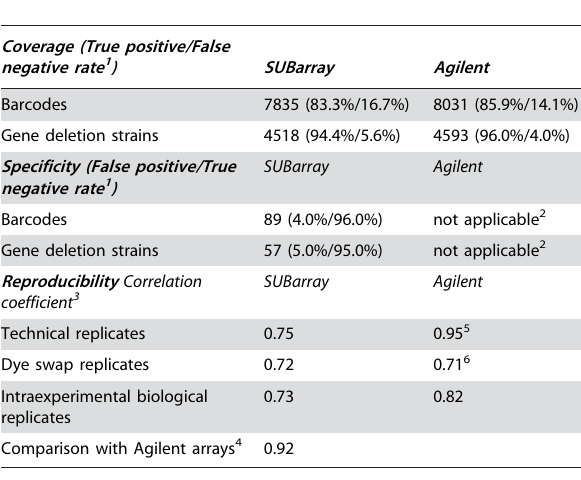
Table 1. Coverage, specificity, and reproducibility of unmodified 20mer